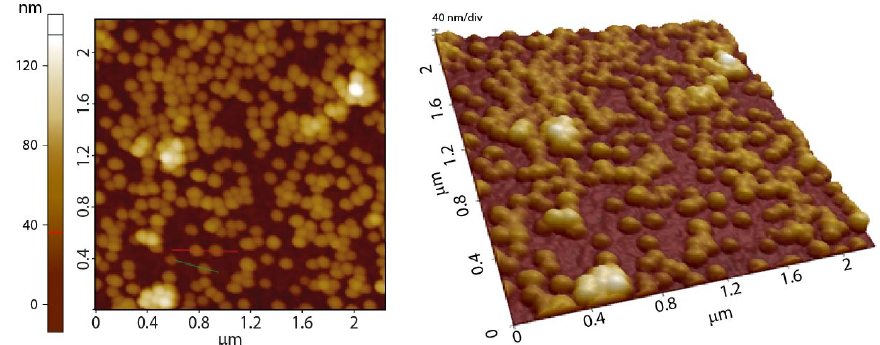
Figure 8. AFM topography micrographs of SiO 2 (50 nm) deposited over Au wafers.